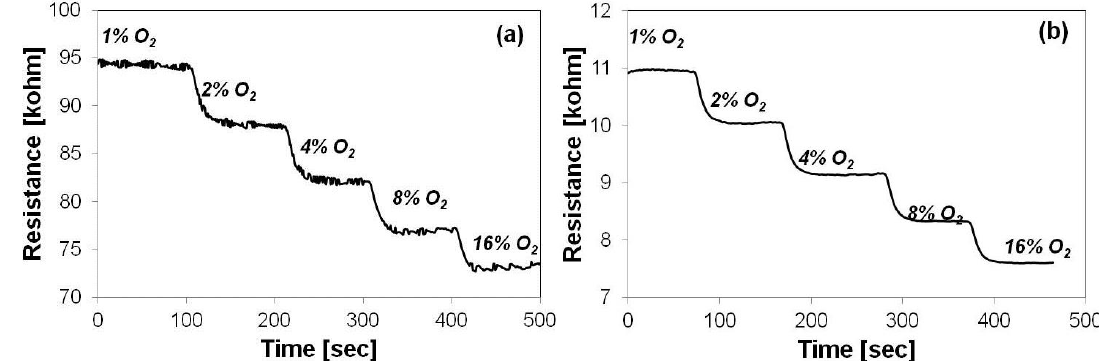
Figure 6. Oxygen sensor response in dry nitrogen atmosphere (1% – 16% O 2 ) for: ( a ) Sono-STFO40 and ( b )